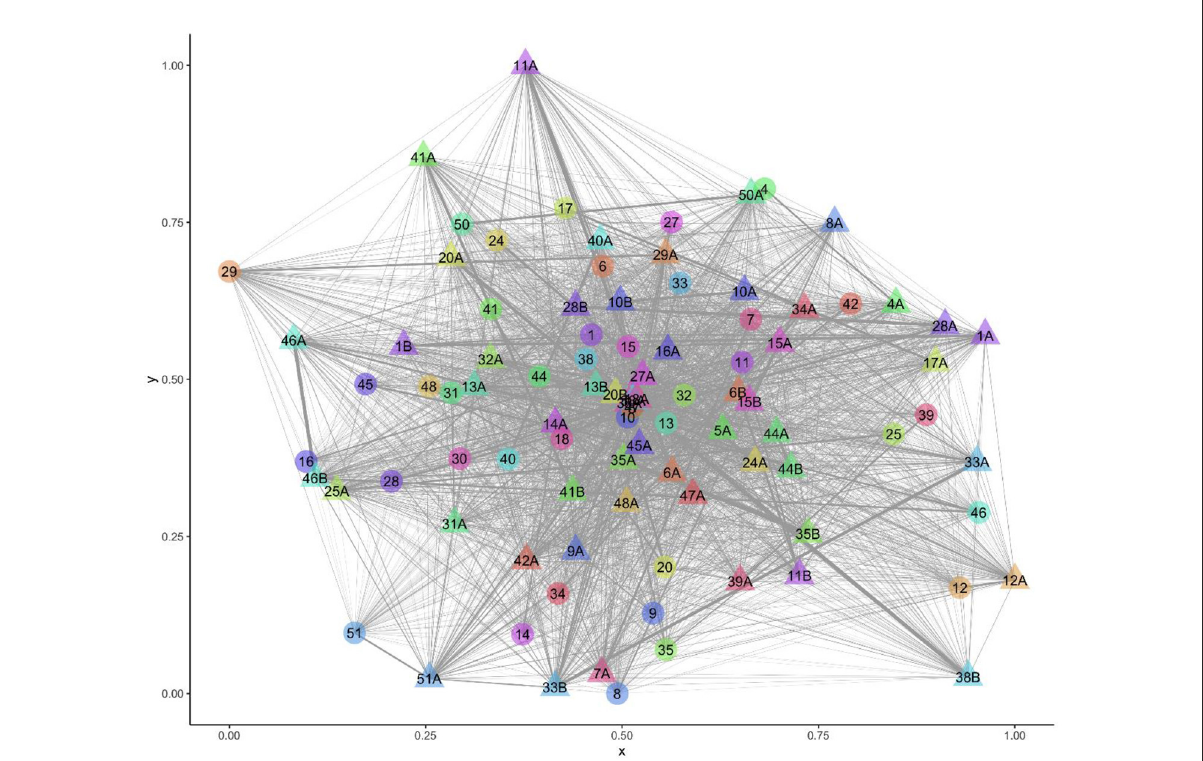
FIGURE1 Visualization of the network over the entire study period with 94 nodes (sheep) and 4,358 edges (contacts). Ewe and lamb family groups have the same number, letter A denotes a lamb and B a twin to lamb